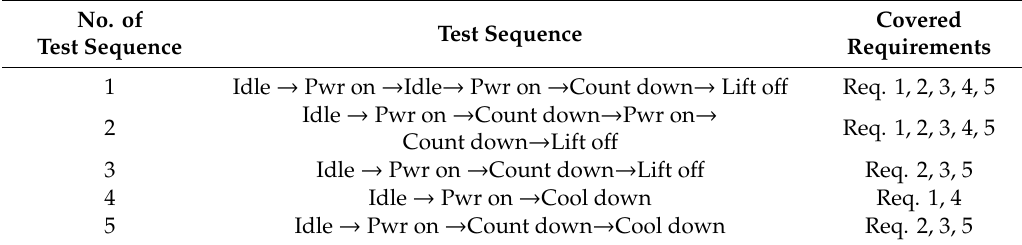
Table 2. Test suite by the proposed method.